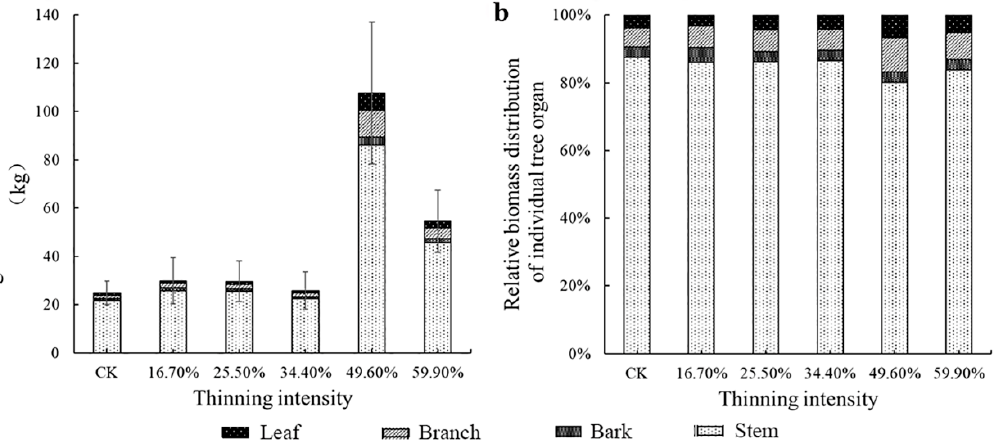
Figure 5. The average individual tree organ biomass and its allocation of birch. Note: ( a ) is birch average biomass of individual tree, ( b ) is birch relative biomass distribution of individual tree organ.